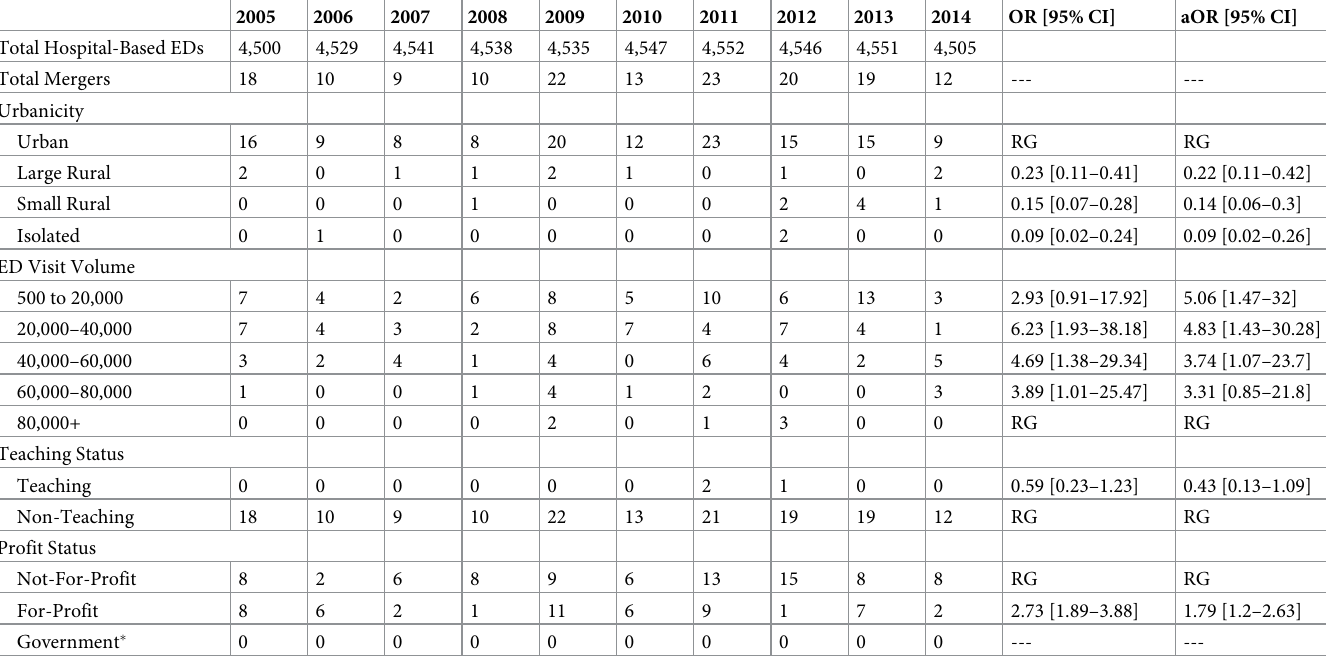
Table 2. Characteristics and risk factors for hospital-based ED mergers, 2005 to 2014.